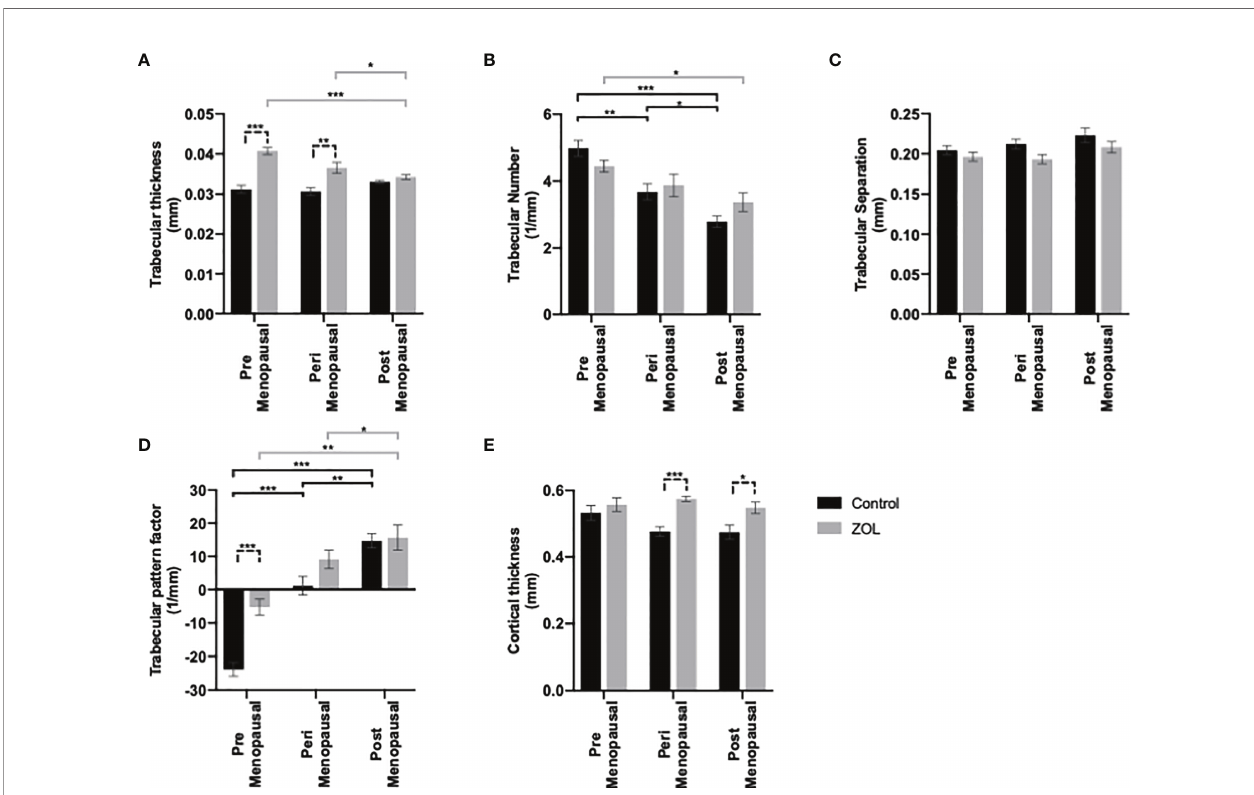
FIGURE 2 | Effects of pre-, post-, and peri-menopausal concentrations of oestradiol ± zoledronic acid on trabecular and cortical bone in mouse tibiae. Twelve- week-old immunocompetent BALB/c mice underwent ovariectomy, and 0, 1.38, or 12.5 mg/L oestradiol was immediately supplemented via their drinking water. Three days later, 10 mice from each group received subcutaneous injection of 100 m g/kg zoledronic acid or saline control. All mice received a daily injection of 40 m g/kg goserelin. All data shown are 2 weeks following ovariectomy/oestradiol supplementation. Histograms are all mean ± SD for tibae from 10 mice per group following m CT analysis of trabecular thickness in mm (A) , trabecular number (B) , trabecular separation (C) , trabecular pattern factor (D) , and cortical thickness (E) . *p < 0.01, **p < 0.001, and ***p <